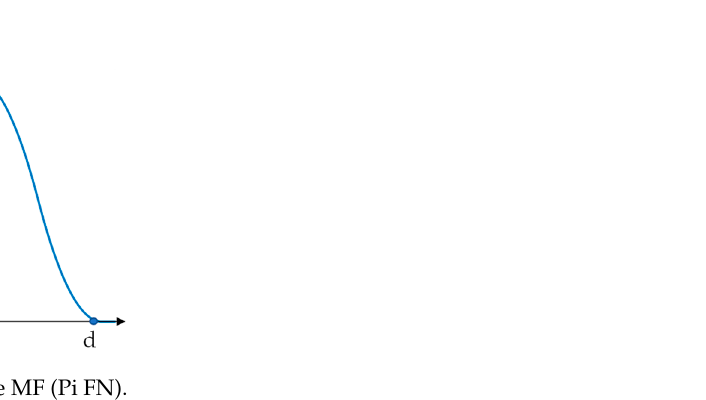
Figure 4. The shape of the MF (Pi FN).